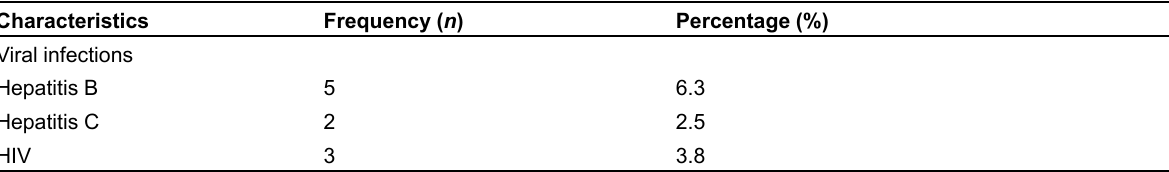
Table 2. Distribution of characteristics in the study population ( continued )